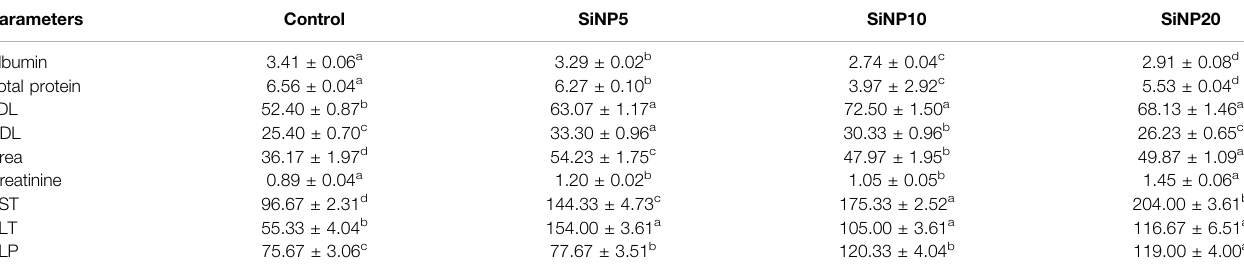
TABLE 6 | Serum biochemical parameters of rats after 96-h gavage with different levels of silica nanoparticles including zero (as the control), 5 (SiNP5), 10 (SiNP10), and 20 (SiNP20).